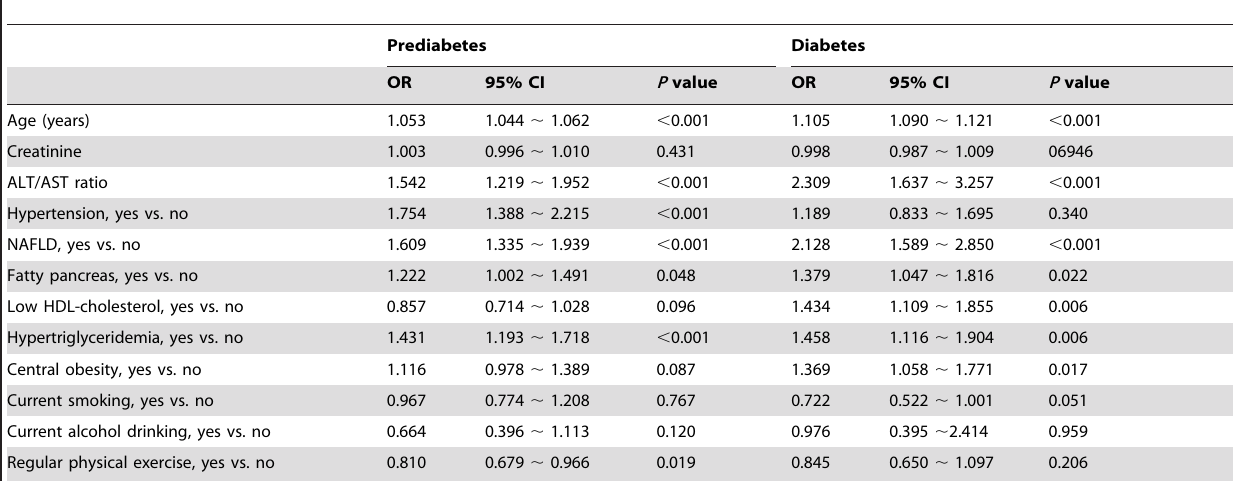
Table 4. Logistic regression analysis for factors associated with prediabetes and diabetes in male